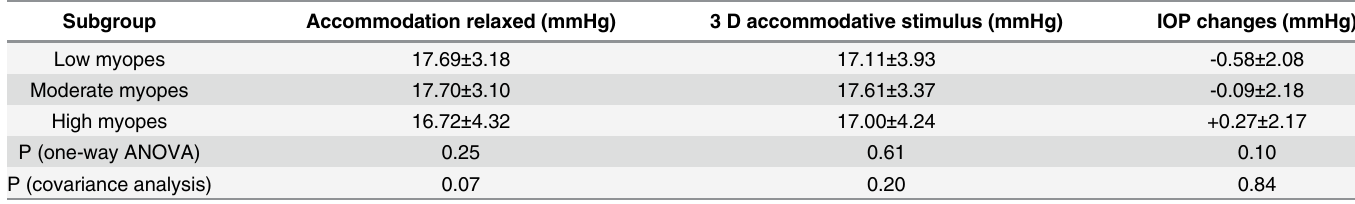
The IOP of low, moderate and high progressing myopes before and after 3 D accommodative stimulus were presented. One-way ANOVA and covariance analysis were employed to determine the between-subgroup difference of IOPs. No statistically signi fi cant difference was detected between